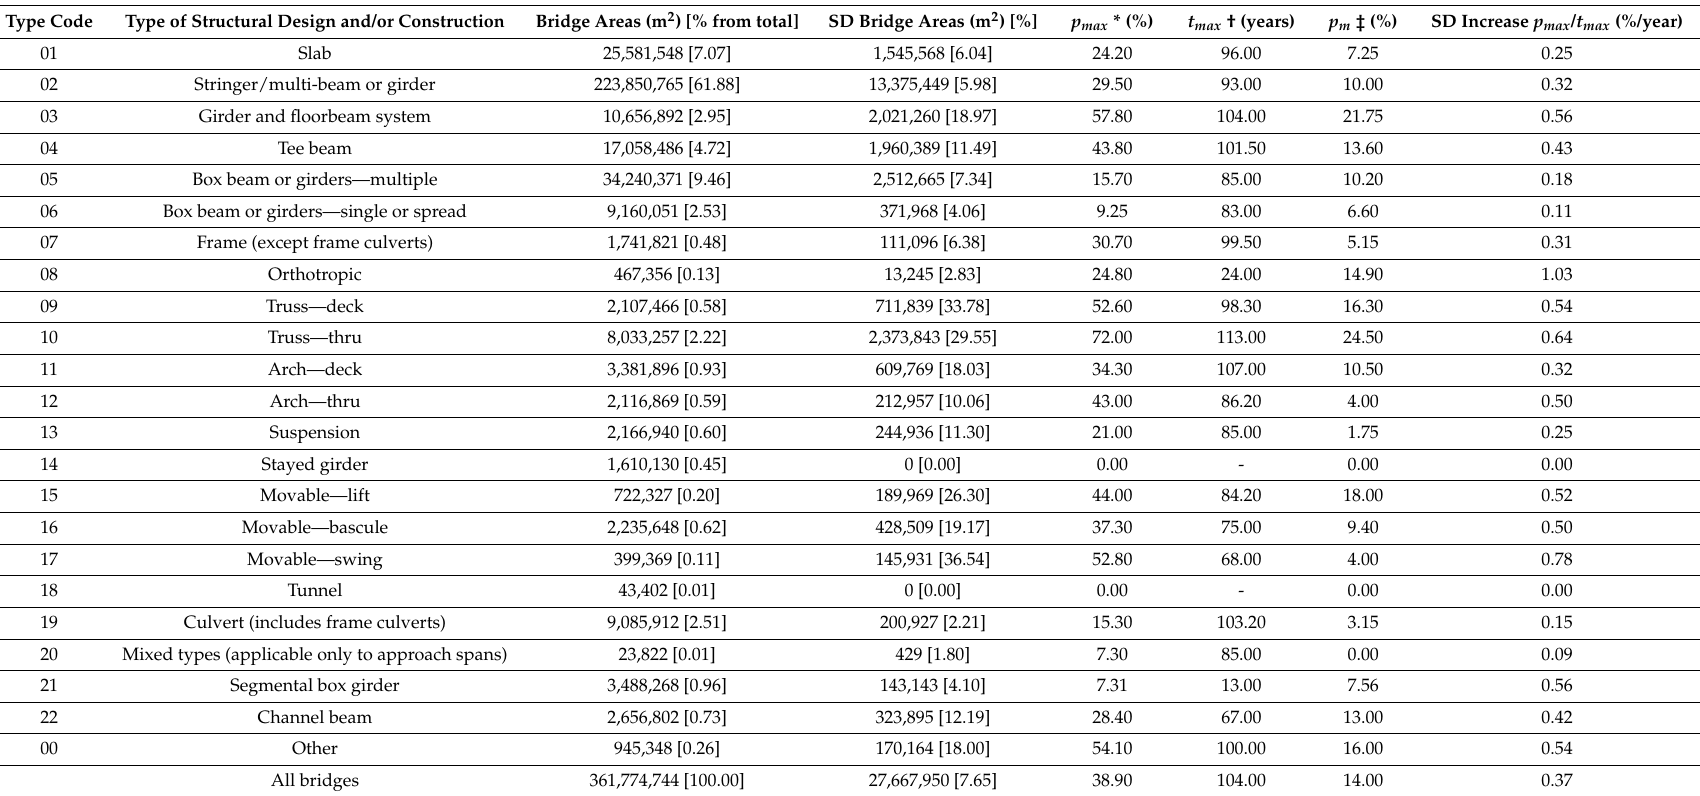
Table 2. Areas of predominant type of structural design and/or construction for bridge main